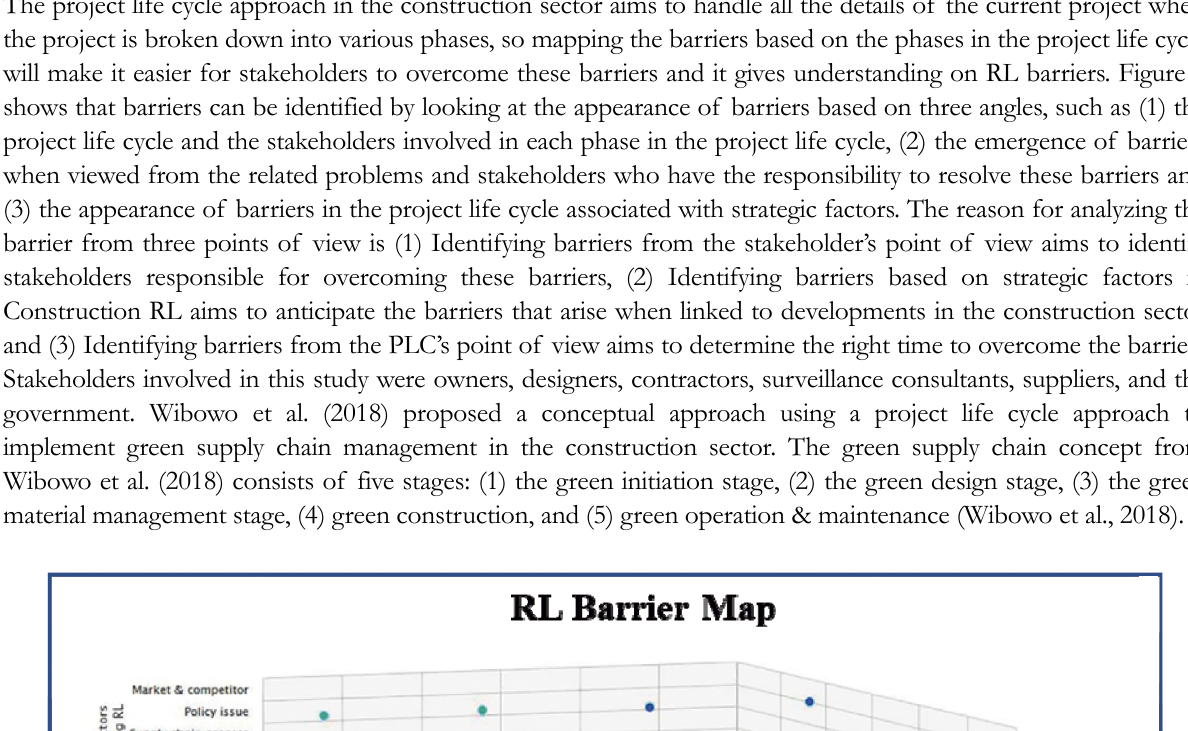
Table 4. Top seven barriers in RL implementation